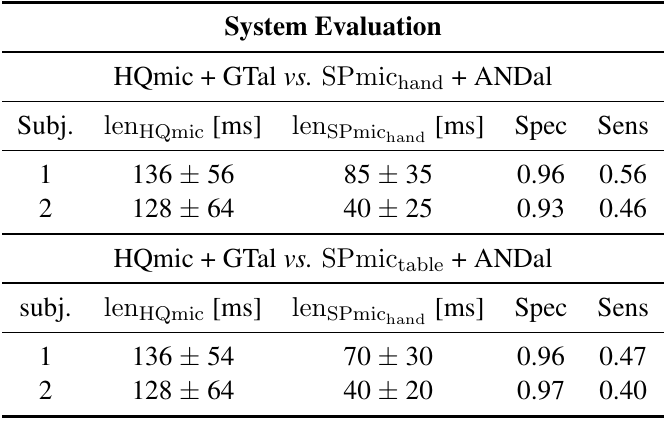
Table 5. Overall estimation of the system: segment lengths (median ± MAD), specificity (Spec) and sensitivity (Sens) estimated using the two different systems.